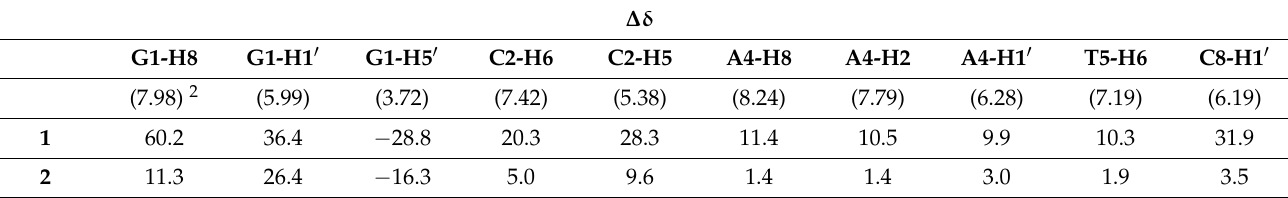
Figure 6. The chemical shift changes of the proton signals of 1 ( a ) and 2 ( b ), ∆ δ [Hz], during titration by octamer 3 (DNA) , as a function of the concentration of 3 [mM]; D 2 O buffer, (25 mM NaCl/25 mM K 3 PO 4 ), pH 6.0, temp. 10 ◦ C. Table 5. The chemical shift changes, ∆ δ 1 [Hz], of proton signals of octamer 3 in D 2 O buffer (25 mM NaCl/25 mM K 3 PO 4 ), pH 6.0, temp. 10 ◦ C, upon interaction with 1 or 2 at a concentration of octamer 3 equal to 0.02 mM and a concentration of 1 or 2 equal to 0.29